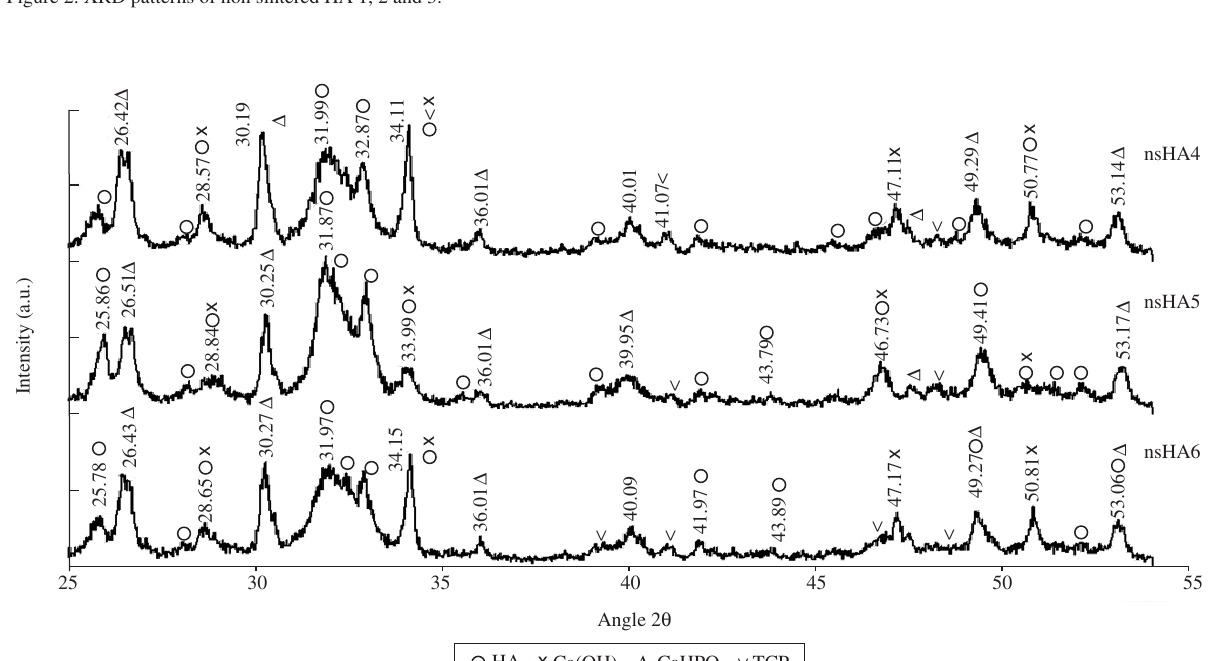
Figure 3. XRD patterns of non sintered HA 4, 5 and